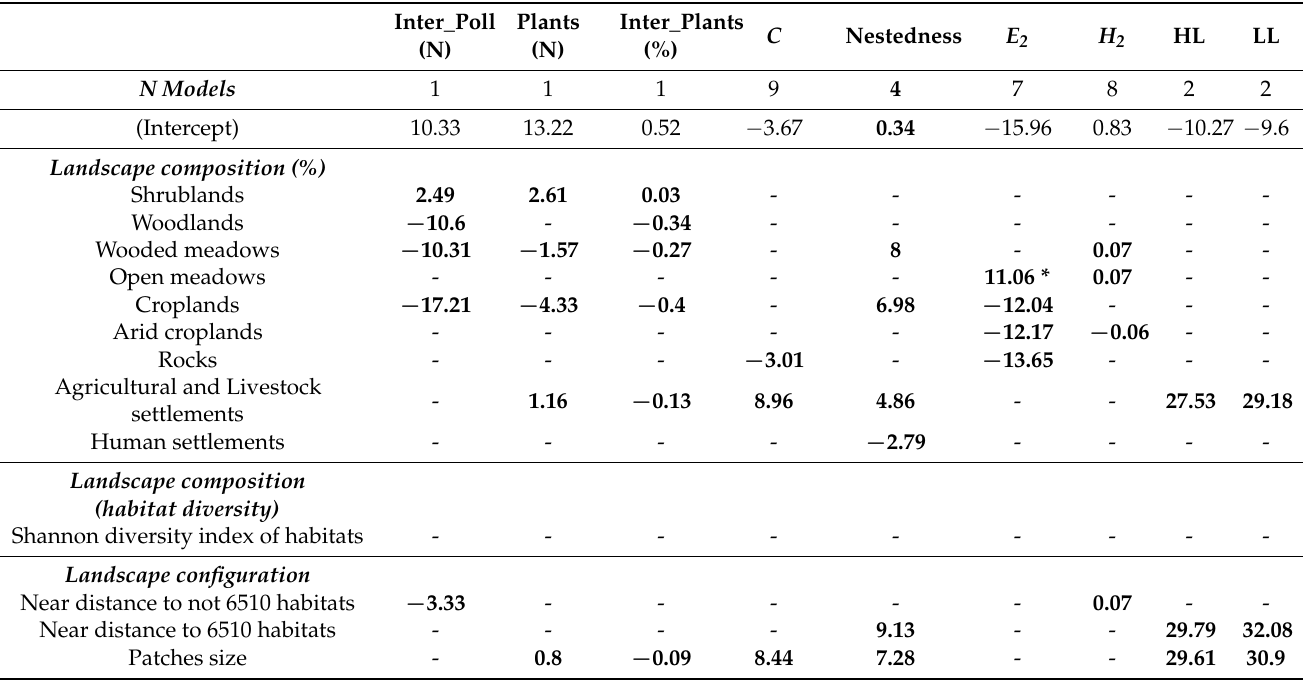
Table 2. Results of multi-model inference carried out through generalized linear models to estimate the effects of landscape composition and configuration on plant and pollinators richness and on seven network descriptors. Average standardized coefficient ( β ) of significant explanatory variables from models with ∆ AICc <2 are shown (see Table S3 for more details). Values in bold indicate the level of significance ( p ) <0.001 while asterisks (*) indicate the level of significance < 0.05. Explanatory variables are in columns; response variables are in